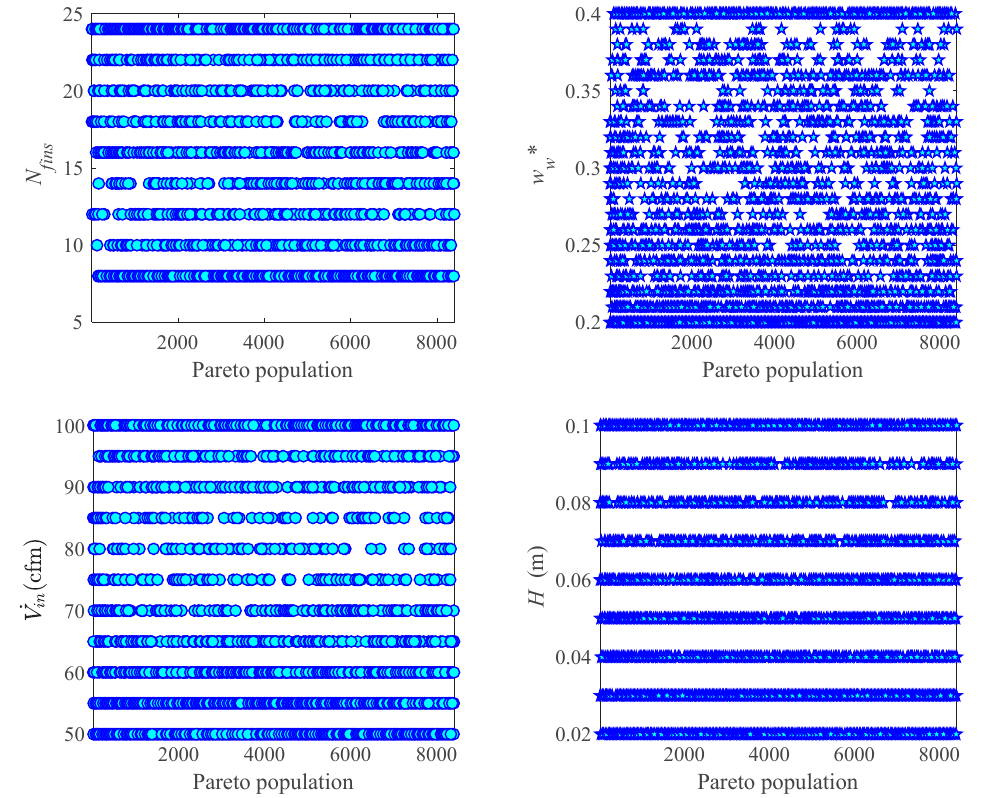
Figure 3. Design variables scatter points on the Pareto front.